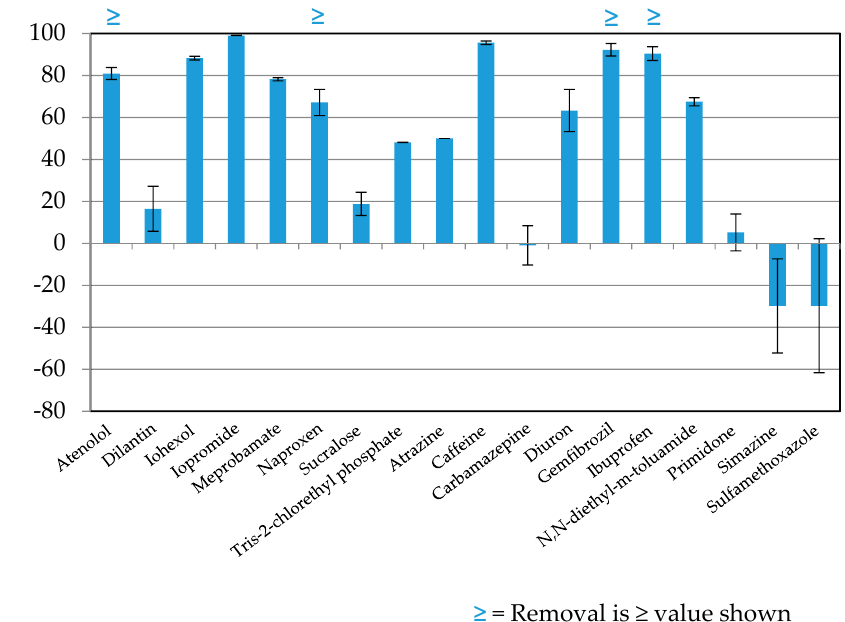
Figure 7. Removal of CECs in RFS (Comparing Source and Product Water). Values are the mean of two sampling events from the previous figure. Error bars represent one standard deviation. In cases where the product water concentration was non-detectable, removal is calculated using the method reporting limit (hence removal is ≥ value shown).